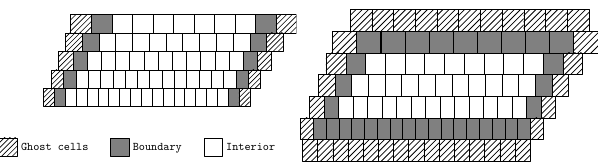
Table 3. Configuration for one of the 158 Sandy Bridge